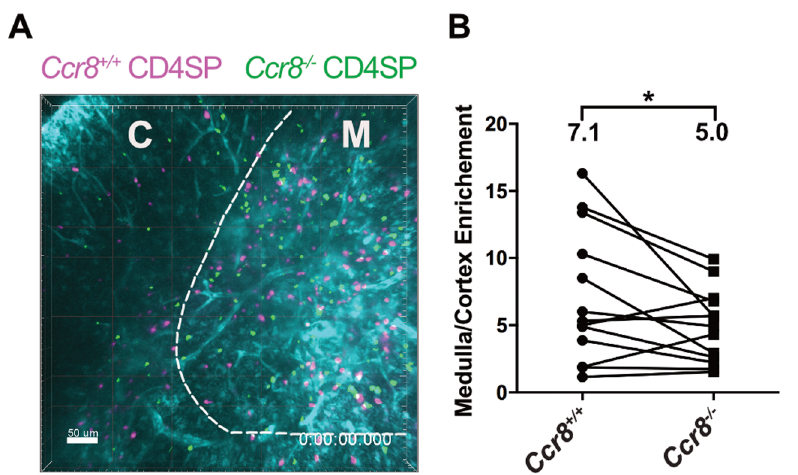
Fig 5. CCR8 promotes medullary enrichment of CD4SP thymocytes. (A) A maximum intensity projection of Ccr8 +/+ (pink) and Ccr8 -/- (green) CD4SP thymocytes in live pCX-EGFP (cyan) thymic slices, from 2-photon fluorescence microscopy images. The boundary between cortex (C) and medulla (M) is indicated with a dashed line. Bar 50 μ m; acquired with a 20X objective. See also S1 Movie. (B) The density of cells (cells/ μ m 2 ) in the medulla and in the cortex was calculated from images as in (A), and enrichment of CD4SP cells in the medulla was determined as a ratio of medullary to cortical densities. CD4SP medullary enrichment was calculated from three independent imaging experiments, with a total of 11 slices analyzed. (cid:3) p < 0.05 (paired Student’s t -test).